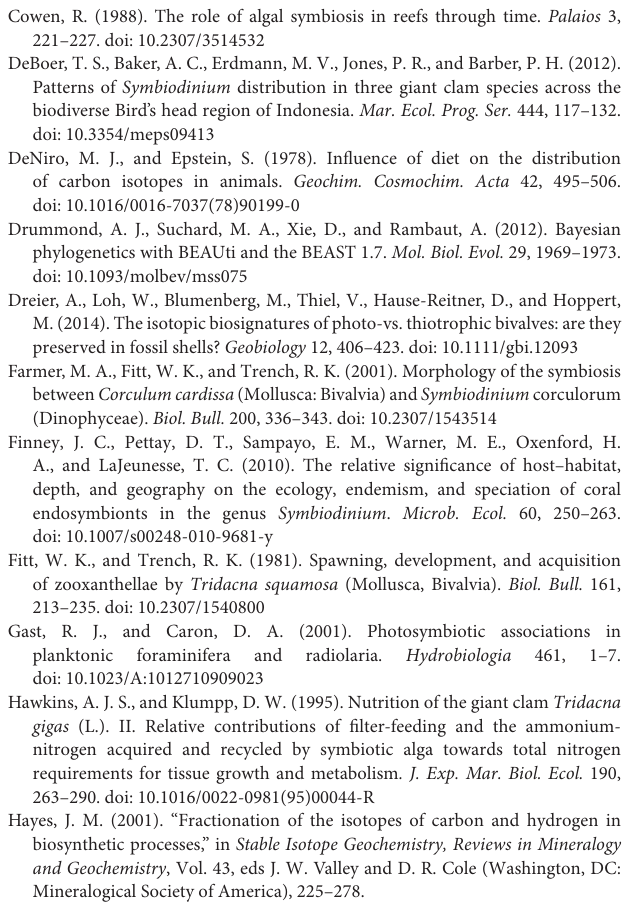
distribution, symbiont type, and genetic markers